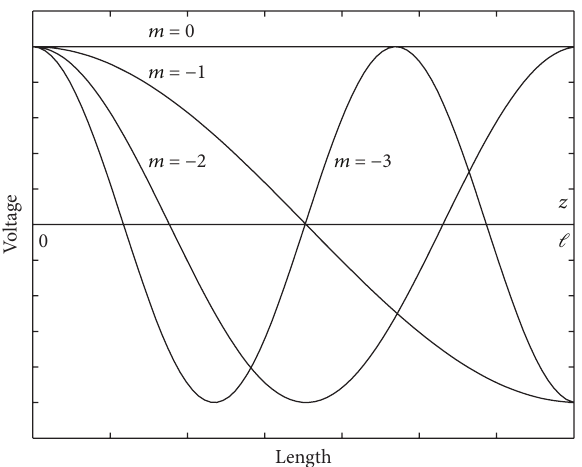
Figure 2: Voltage distribution in case of open-circuited TL of length ℓ . Mode 𝑚 = 0 represents the ZOR with infinite guided